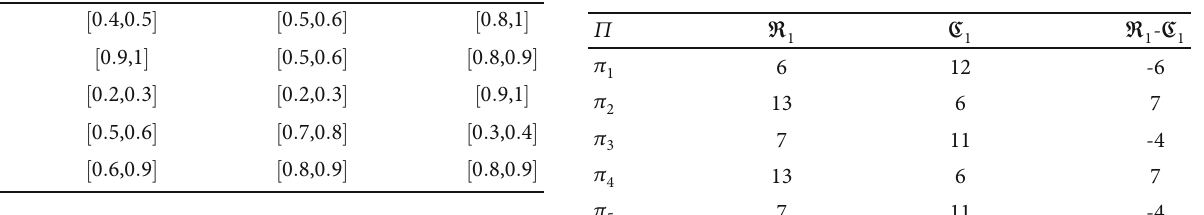
Table 7: The fi rst positive pole score table.